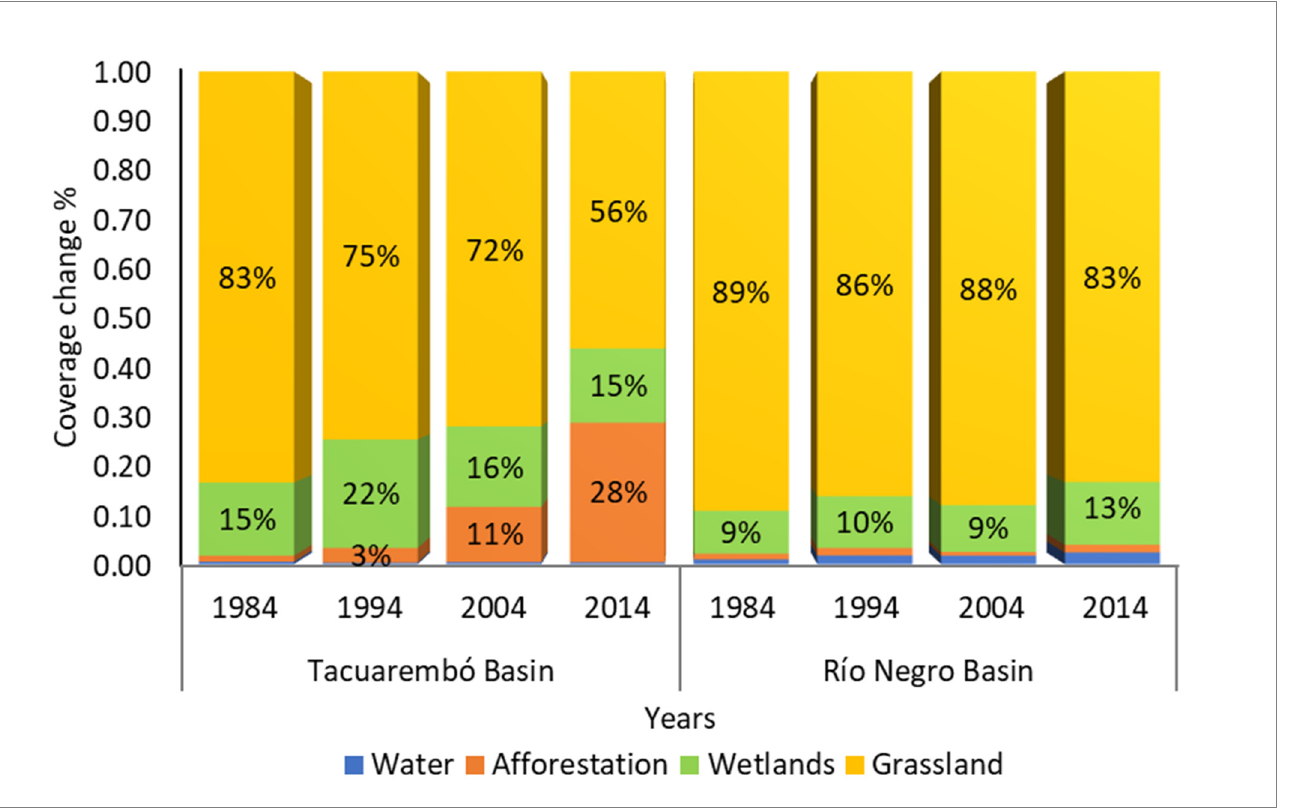
Figure 5. Change in coverage expressed in % in four moments 1984, 1994, 2004, and 2014 of the coverage of bodies of water, forestry, wetlands, and grasslands. Unlabeled values did not exceed